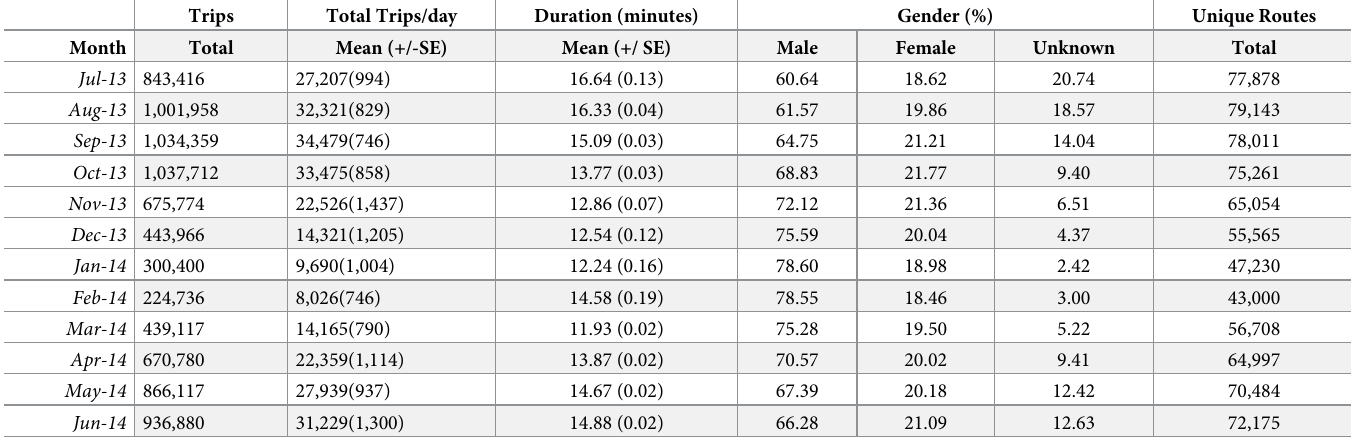
Table 2. The total number of bike trips between July 2013 and June 2014, the mean number of trips per day (+/-SE), mean durations (+/-SE), gender breakdown and the number of unique routes taken during each month. Trips Total Trips/day Duration (minutes) Gender (%) Unique Routes